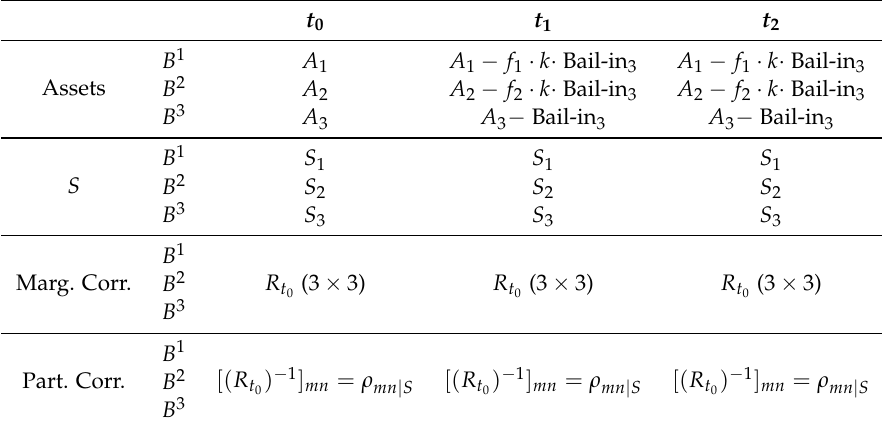
Table 3. Variables’ time-evolution,